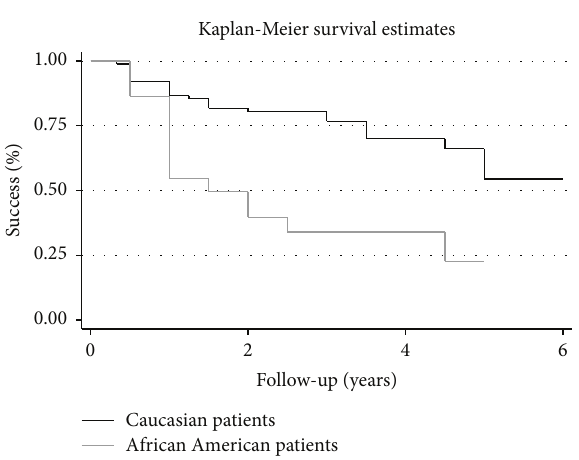
Figure 1: Percentage of success after Ahmed Glaucoma Valve implantation in Caucasian and African American patients, using failure definition of intraocular pressure greater than 18 mmHg and less than 5 mmHg. Univariate analysis showed that African American ancestry was a risk factor for failure ( 𝑃 = 0.001